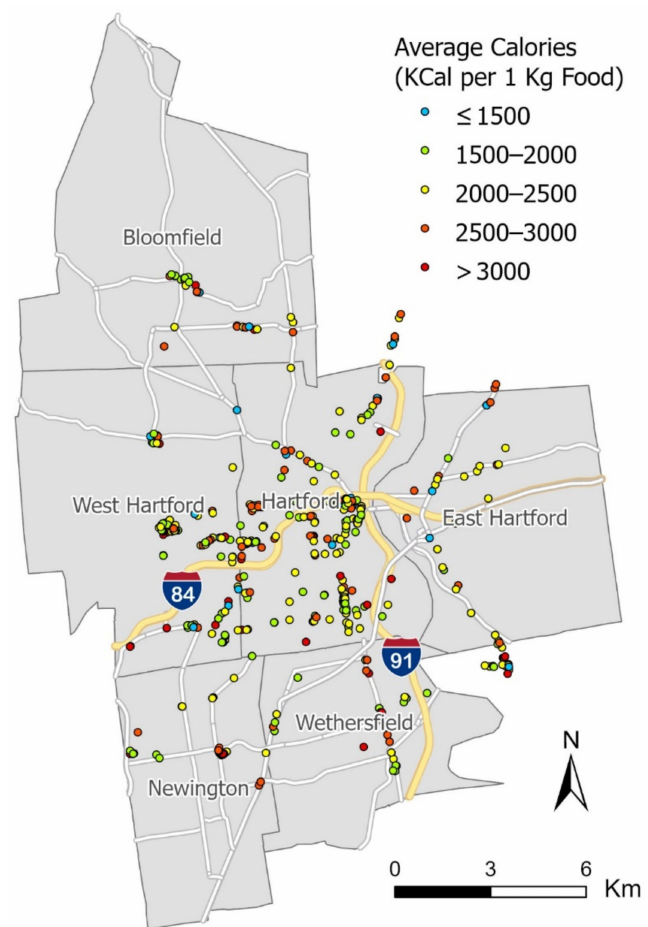
Figure 4. Estimated calorific level of restaurants in the study